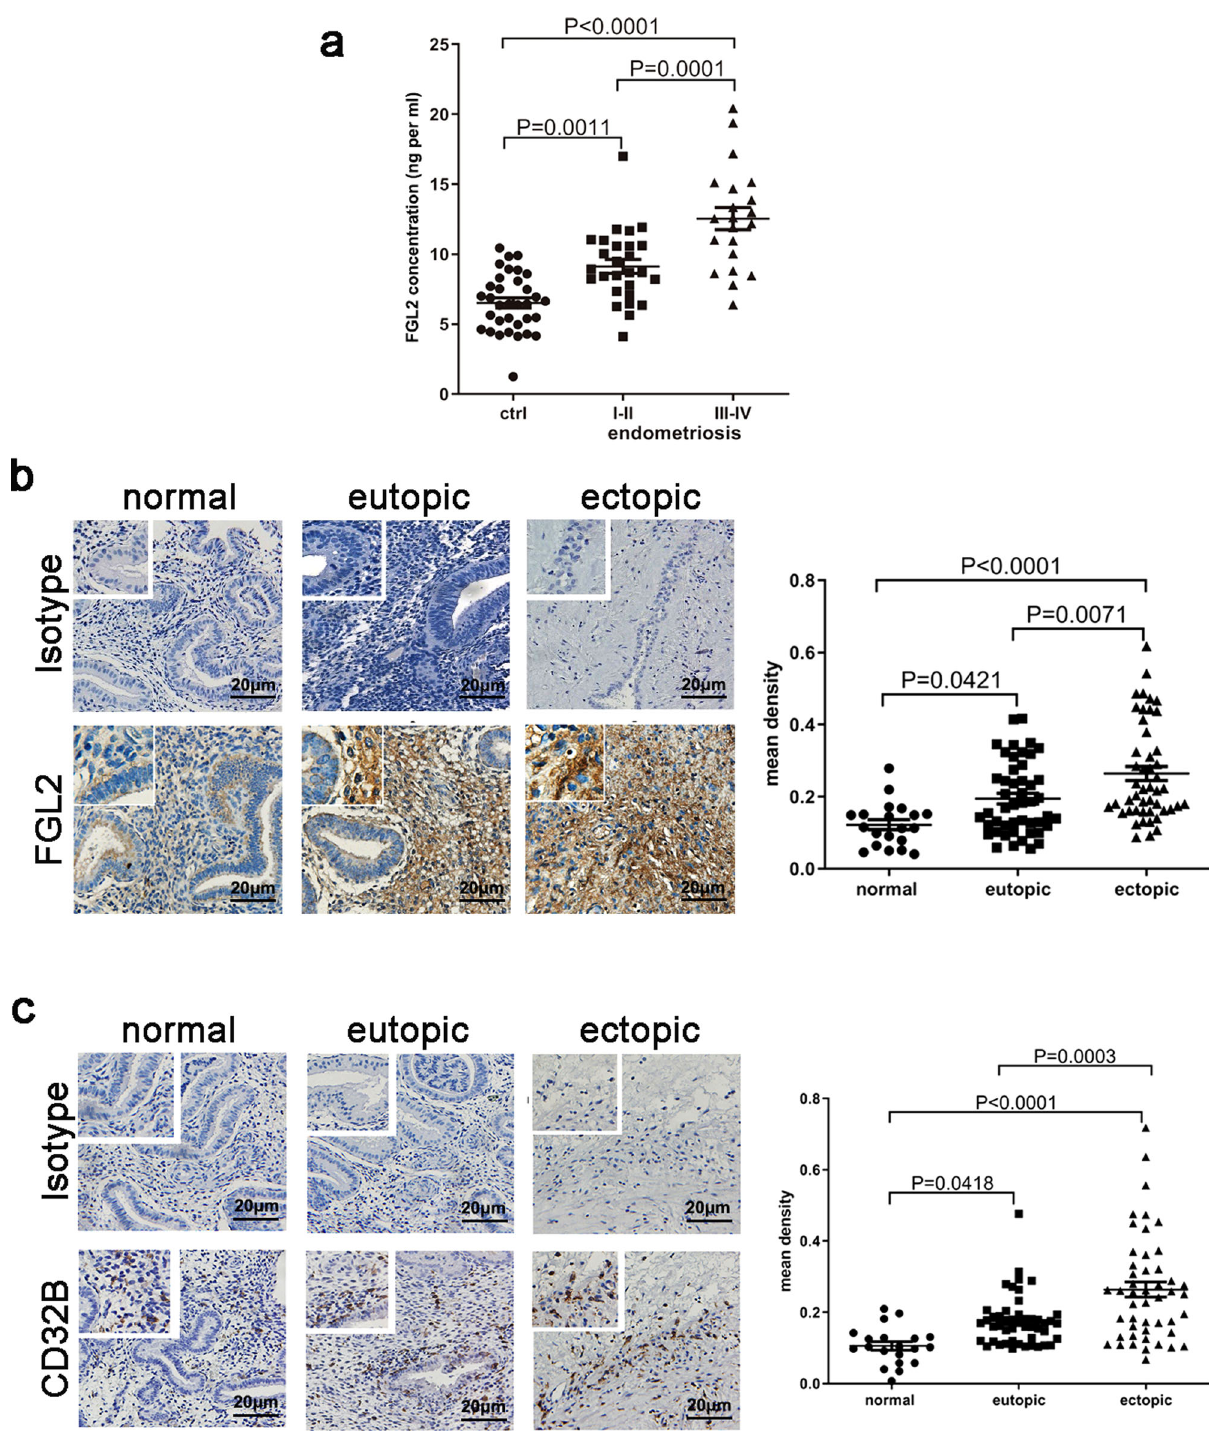
Fig. 1 FGL2 levels in endometrium, ectopic tissues, and peritoneal fl uid of women with or without endometriosis. a Concentrations of sFGL2 in peritoneal fl uid of women with (stage I – II, stage III – IV) or without endometriosis. b Immunohistochemistry staining of FGL2 in normal, eutopic endometrium and ectopic lesions; the density was analyzed using Image Pro Plus 6.0 software. c Immunohistochemistry staining of CD32B in normal, eutopic endometrium and ectopic tissues; densities were analyzed using Image Pro Plus 6.0 software. Data represent the mean value ± The expression of FGL2 and its receptor CD32B in endome- naive T cells, NK cells, Teffs and Tregs (peripheral venous blood trium and immune cells . To better understand the source of samples from healthy volunteers) by using FGL2 ELISA kits. We sFGL2, we measured sFGL2 concentrations in cell culture super- also determined mRNA levels of FGL2 by using qRT-PCR. As natant of endometrial stromal cells (ESCs) and endometrial epi- shown in Fig. 2, the secretion of sFGL2 was mainly found in Tregs thelial cells (EECs) (primary culture of ESCs and EECs from and naive T cells (Fig. 2a). FGL2 qRT-PCR also showed the women without endometriosis) as well as monocyte, macrophages, highest levels of expression in Tregs (Fig. 2b). We also detected